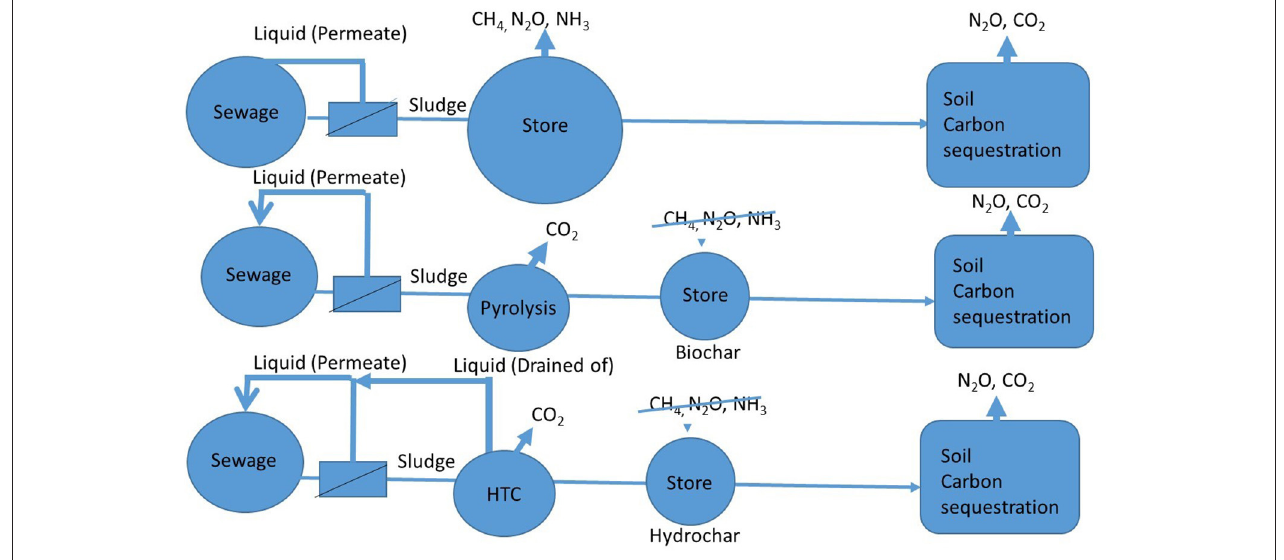
FIGURE 5 | GHG emission from scenario of dairy sludge management no treatment of sludge, pyrolysis, and hydrothermal (HTC) treatment of